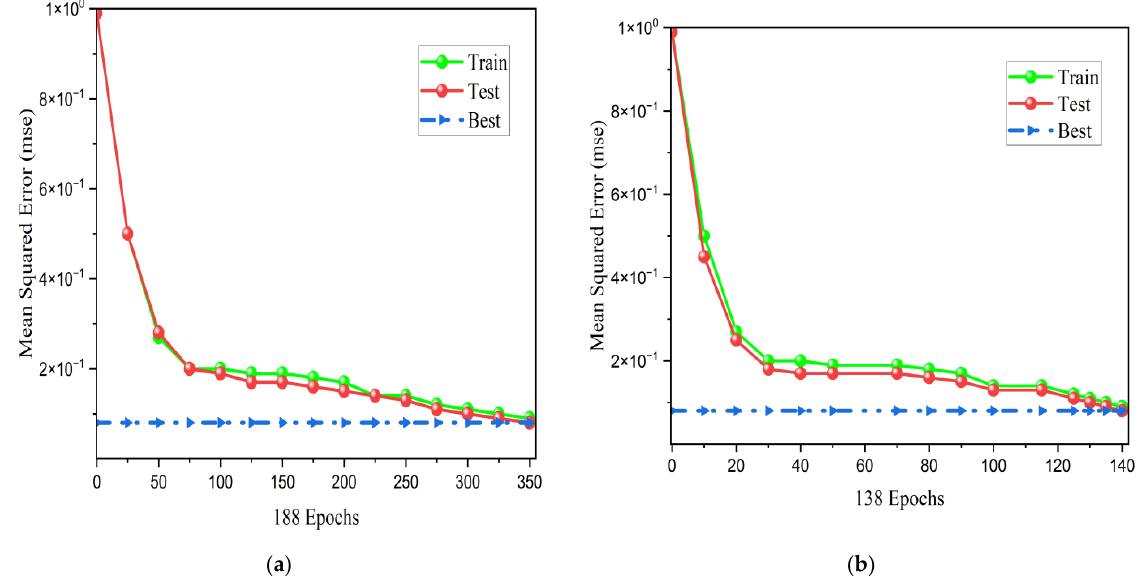
Figure 10. Plots of mean square error results for porous cavities (BRT (ANN)). ( a ) 188 Epochs. ( b ) 138